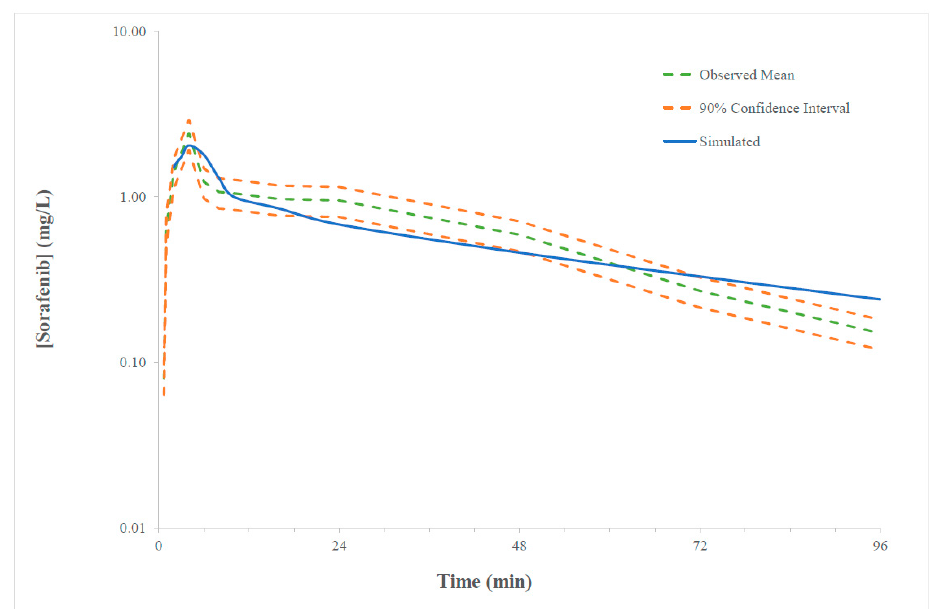
Figure 1. Representative overlay of simulated and observed (range) plasma concentration time curve of sorafenib (0–96 h) following 400 mg twice a day dosing. Solid blue line represented the mean model predicted exposure, dashed green line represented the mean observed exposure and dashed orange represented minimal and maximal 90% confidence intervals for the observed data.